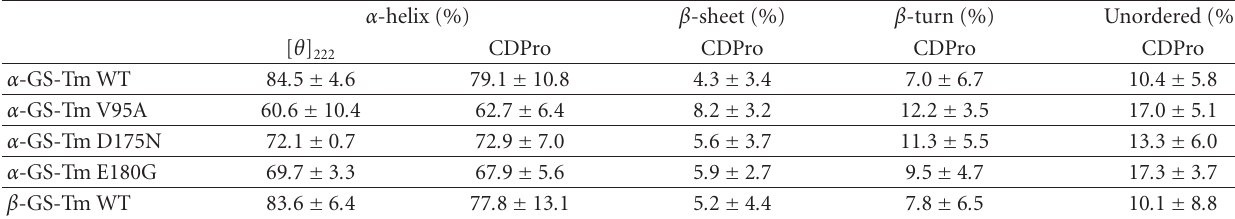
Table 2: Estimates of structural content of WT and mutant tropomyosins.